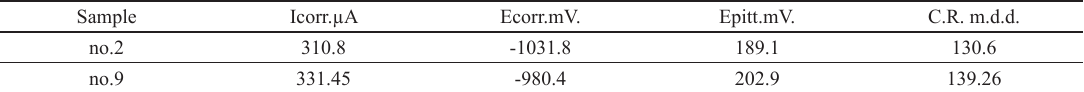
Table 4. The Values obtained from tests curves the potentiated and cyclic anodic polarization technique.